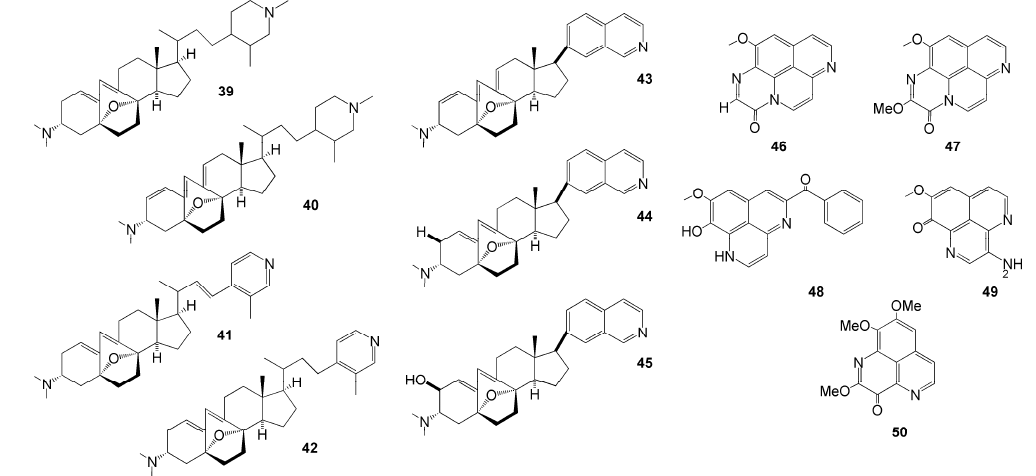
Figure 4. Chemical structures of 39–50.